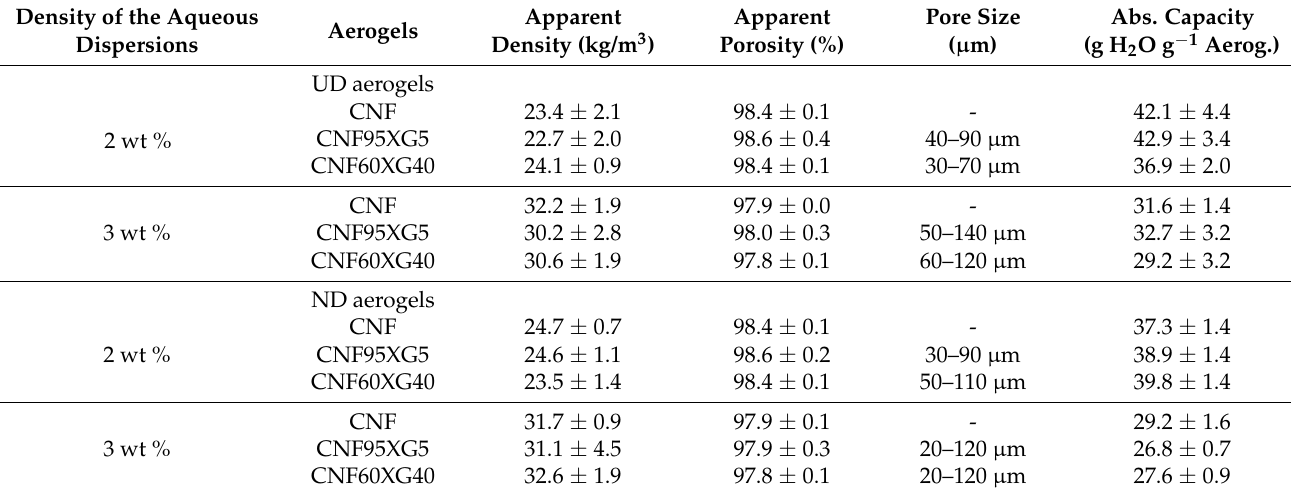
Table 1. Characteristics of CNF and CNF/XG aerogels prepared from the aqueous dispersions. Density of the Aqueous